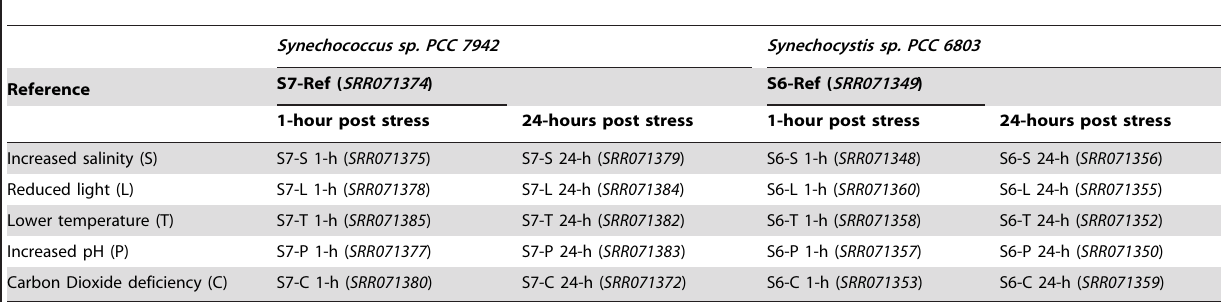
Table 1. Growth Conditions applied on the two organisms and their run ids from NCBI